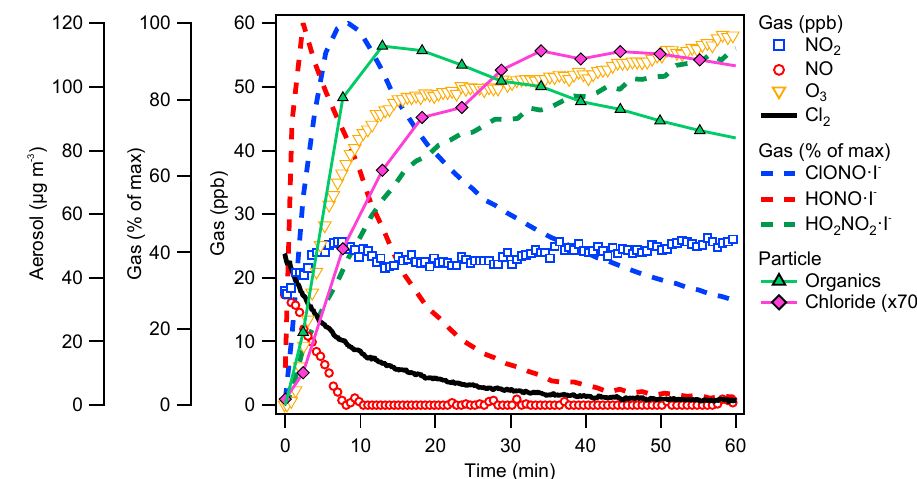
Figure 1. Representative trends of SOA and trace-gas species during the photooxidation period. Data from dodecane oxidation (Exp. 11) are shown. Particulate chlorine concentrations were multiplied by 70 for ease of comparison. Ions consistent with HONO and HO 2 NO 2 were observed, indicative of secondary HO x chemistry. Formation of ClONO and ClNO 2 due to oxidation of NO 2 by Cl